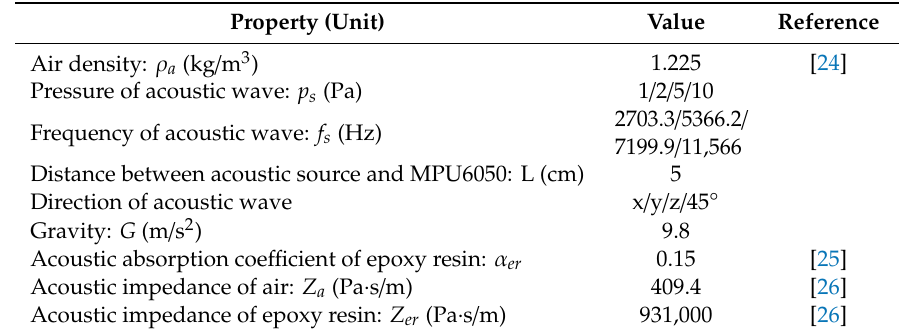
Table 2. Parametric values of variables used in the simulation.